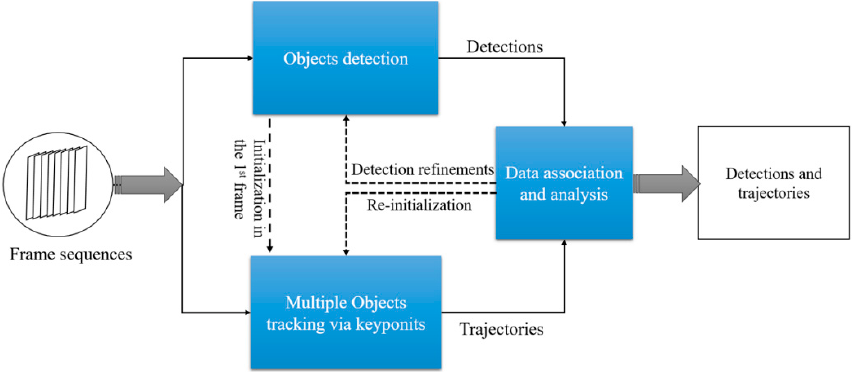
Figure 2. The general framework of proposed method, which couples a CNN ‐ based detection and a multiple objects tracker via a novel hierarchical data association algorithm.